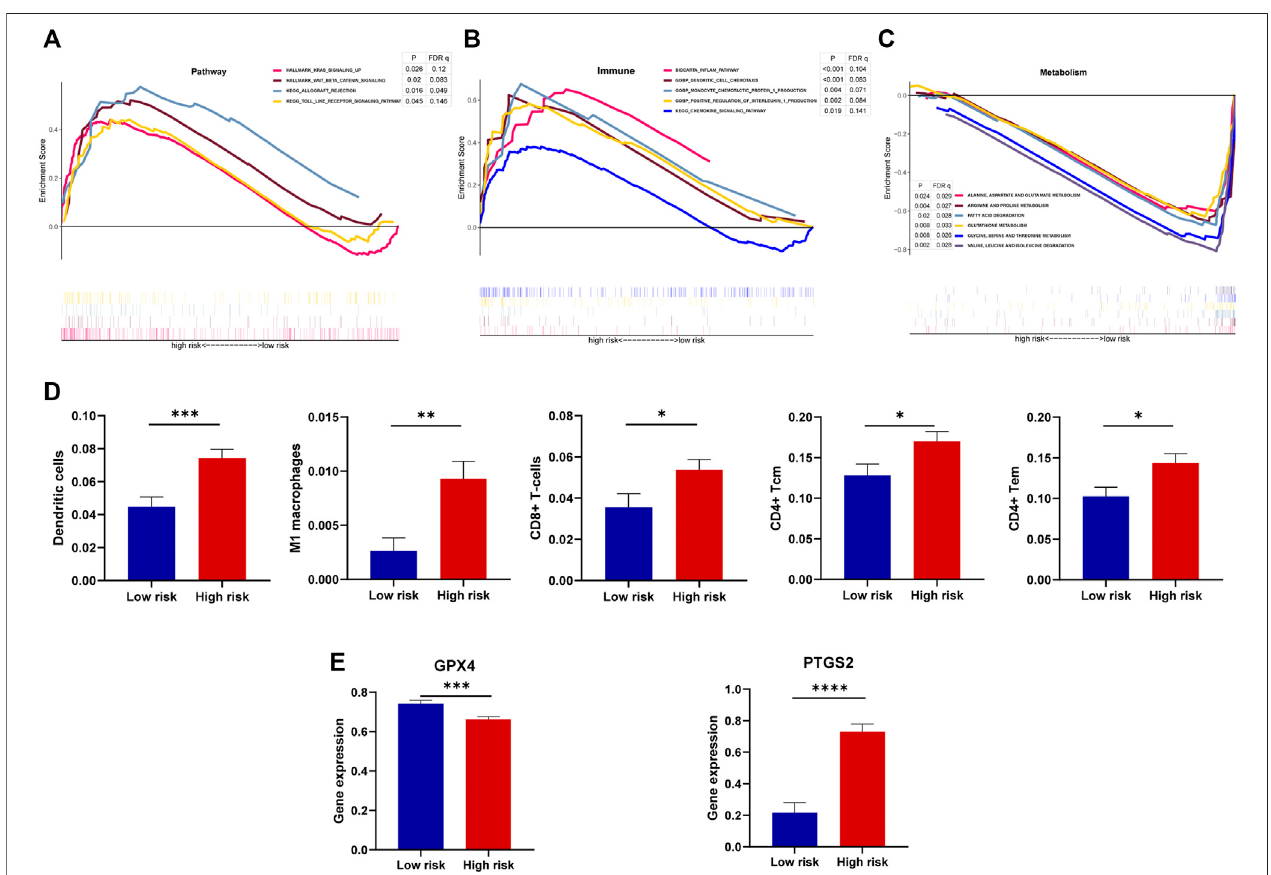
FIGURE 8 | Association of the model with involved function, immune cell in fi ltration, and ferroptosis. (A – C) GSEA showing the involved function of high-risk and low-risk groups in terms of the DGF-related pathway, immune, and metabolism. Terms with p < 0.05 and FDR q < 0.25 were considered statistically signi fi cant. (D) Differences of immune cell in fi ltration between low-risk and high-risk groups, estimated by the xCell algorithm. (E) Gene expression of key ferroptosis markers, namely, GPX4 and PTGS2 between risk groups. *, p < 0.05; **, p < 0.01; ***, p < 0.001; ****, p < 0.0001.